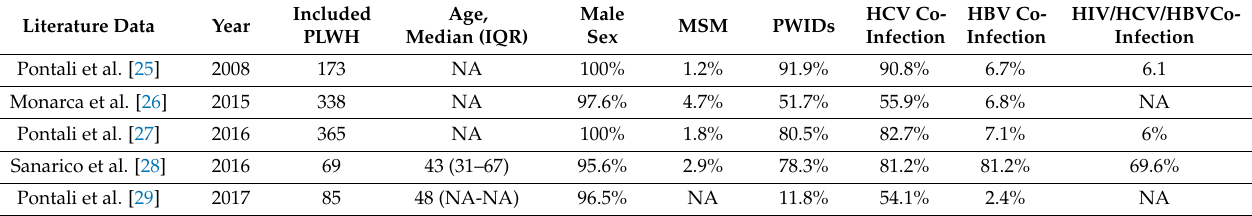
Table 2. Overview on viral hepatitis among people living with HIV (values calculated from available data). Literature